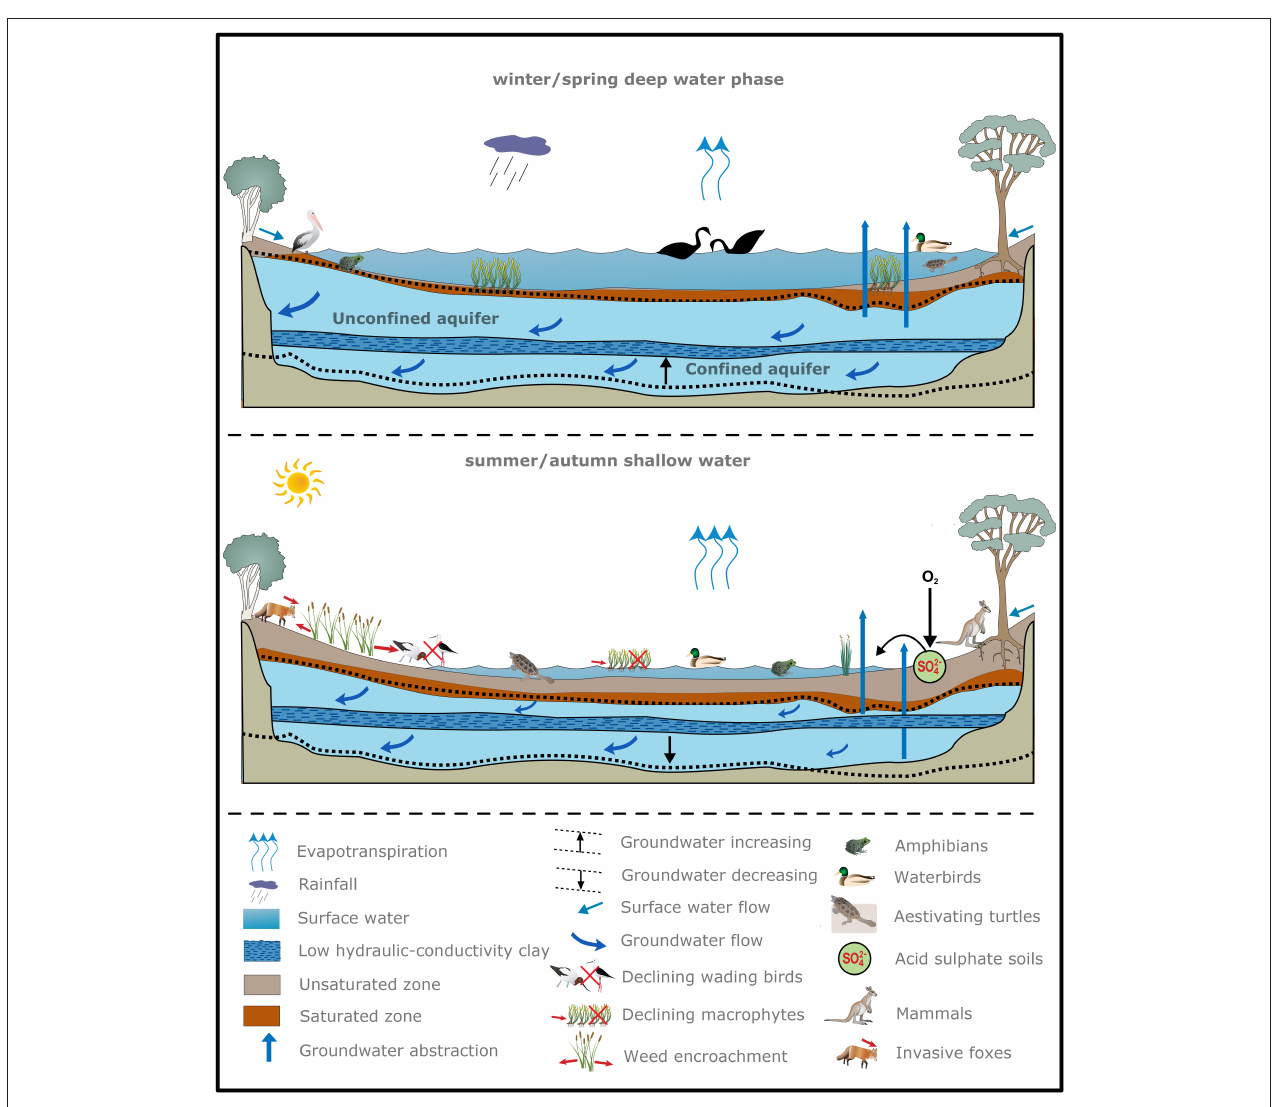
FIGURE 4 | A conceptual, seasonal representation of the hydrology of Forrestdale Lake in a cross-sectional form. Representing the seasonal deep-water and shallow water phases and inter-annual variability. Ecological character identifiers that serve as an early warning sign of potential negative ecological effects are explained for each phase. The superficial groundwater head level provides limited connectivity to surface water level due to a clay layer of the lakebed. This limits groundwater fed surface water in summer but provides a saturated lakebed during summer to support critical ecological functions [ian.umces.edu/media-library (Integration Application Network, 2007)]. Model not-to-scale. Wetland and aquifer system of the Swan Coastal Plain is